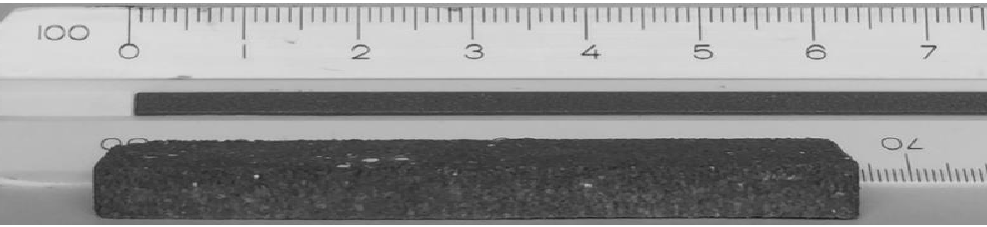
Figure 4. Geometric formation of glass foam in the green state.